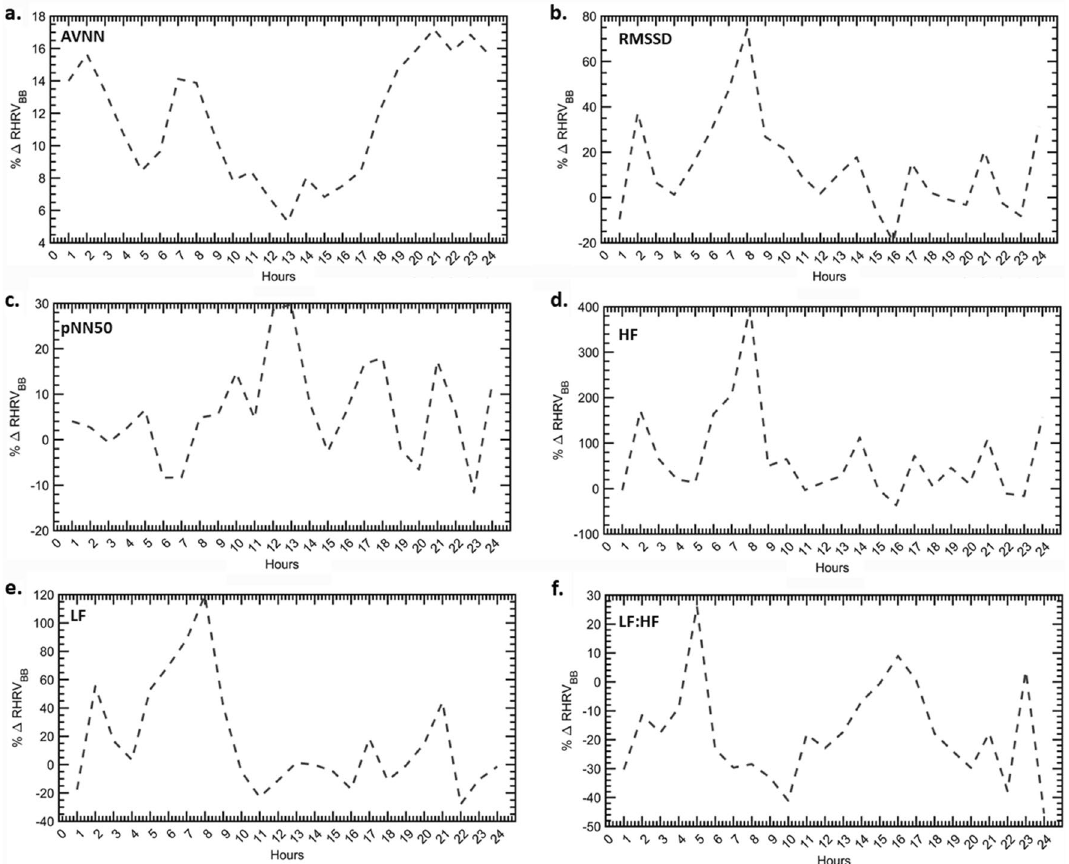
Figure 3. The relative percentage change in HRV features of the BB group relative to NBB for time and frequency domain measures. ( a ) AVNN. ( b ) RMSSD. ( c ) pNN50. ( d ) HF power. ( e ) LF power. ( f ) LF:HF